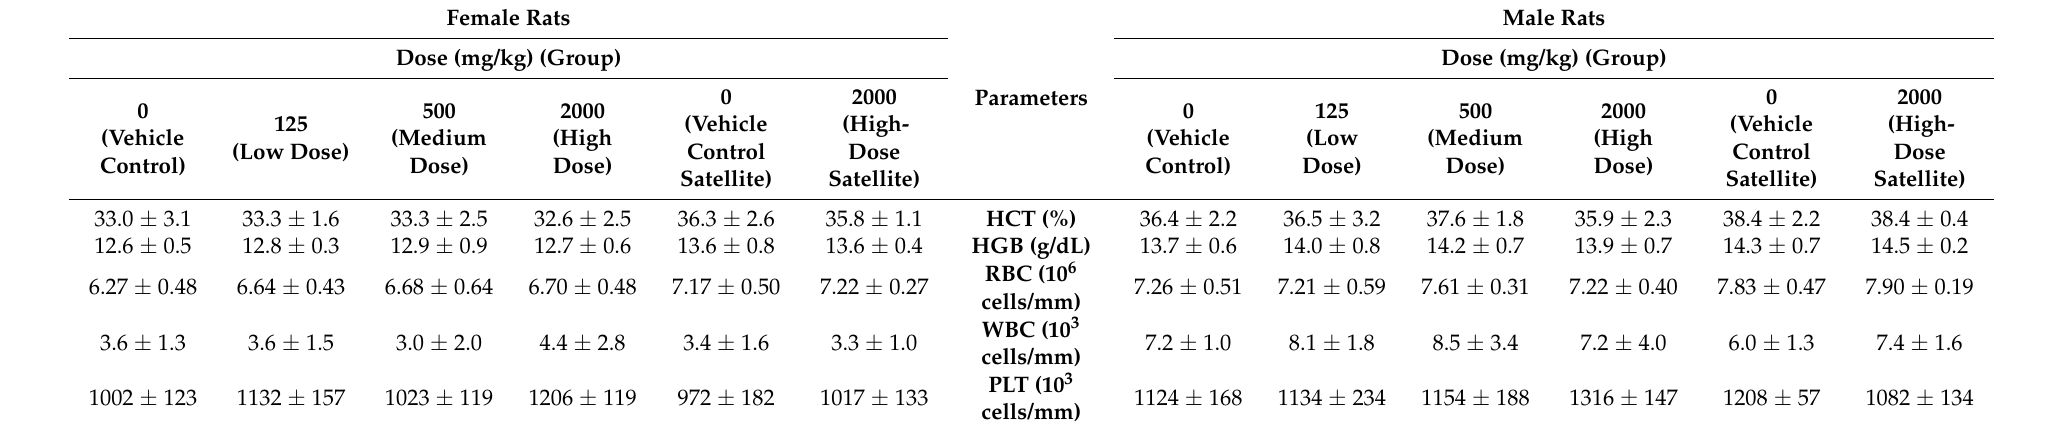
Table 6. Haematology findings in female and male